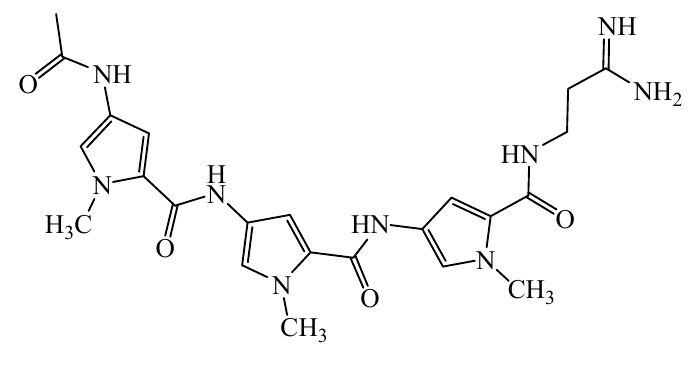
Figure 1. Structure of distamycin